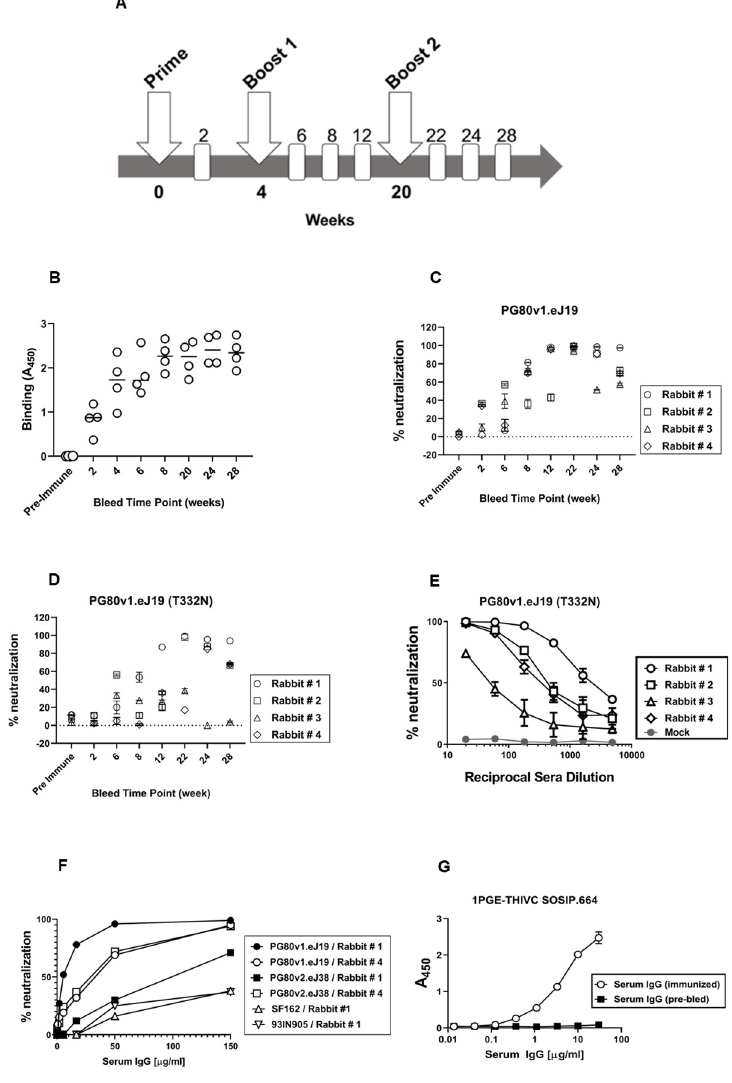
Fig 6. Immunogenicity of 1PGE-THIV in rabbits. A. Schedule of prime, boost and bleed time points. The binding (B) and neutralization of sequence matched (with and without N332) autologous viruses ( C and D ) by sera collected from four rabbits at 1:20 dilutions collected at different time points following prime and boost. E. Dose-dependent neutralization of pseudotyped virus expressing sequenced matched env (PG80v1.eJ19) by sera collected at week 22 following second boost with 1PGE-THIVC. F. Neutralization of pseudoviruses expressing sequence matched (PG80v1. eJ19) and unmatched (PG80v2.eJ38) autologous envs and heterologous tier1 envs (SF162 and 93IN905) by purified serum IgG in a dose-dependent manner; G. Binding of purified serum IgG (week 22; rabbit#1) to 1PGE-THIVC SOSIP trimer by D-7324 sandwich ELISA. and 93IN905) was observed, however with lower magnitude compared to autologous viruses (Fig 6F), which was possibly due to trimer falling apart thereby exposing the immunodomi- nant epitopes in V3 region. Towards confirming the specificity of antibody-mediated virus neutralization, when tested, purified rabbit serum IgG was found to show neutralization of pseudoviruses expressing autologous envs in a dose-dependent manner (Fig 6F); thus, con- firming the concordance of serum (Fig 6E) versus serum IgG mediated virus neutralization. Finally, potent autologous neutralization was correlated with efficient binding of serum IgG